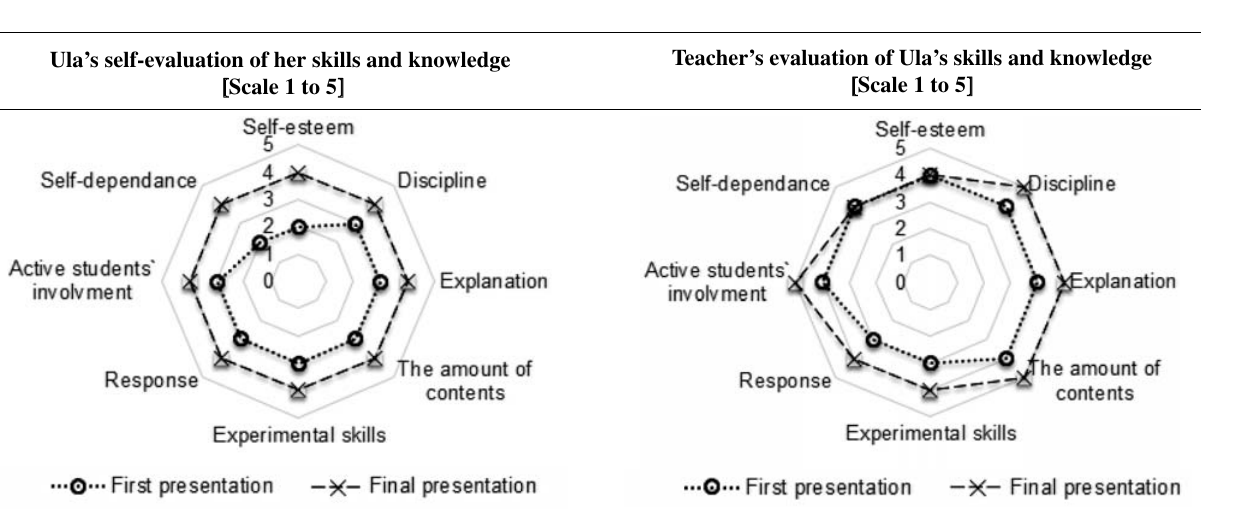
Table 7. Ula’s self-evaluation of her skills and knowledge in specific fields at her first and final presentation during their PPT in comparison with the evaluation of her school